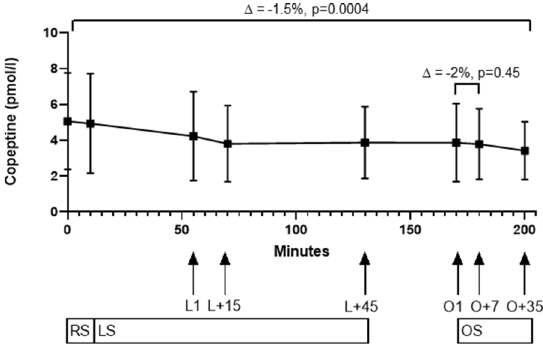
Figure 3. Time plot of copeptin during all test sessions. RS resting session. ∆ = −0.9%, p = 0.14. LS learning session. ∆ = −22%, p = 0.0003. L1 time point when reaching target pain. L + 15 time point L1 plus 15 min. L + 45 time point L1 plus 45 min. OS opioid session. ∆ = −6%, p = 0.1. O1 time point of administration of opioids in addition to target pain. O + 7 7 min after O1. O + 35 35 min after O1. Arrows point to the corresponding time points. Boxes and whiskers represent mean and SD. Spearman rank correlation between copeptin levels and VAS scores at the trial endpoint time showed no correlation between VAS scores and copeptin levels (Spearman r − 0.26 (95% CI −0.65 to 0.25), p =